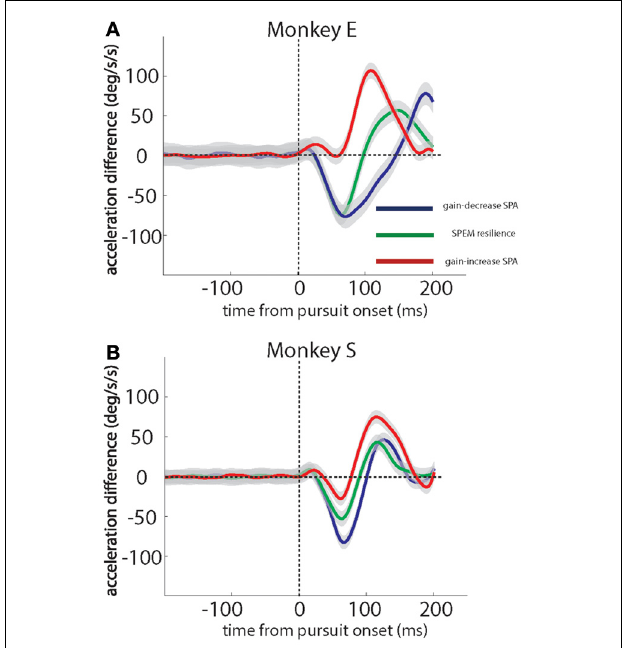
FIGURE 3 | Grand averages of eye acceleration profile differences based on a comparison of the first and the last quarter of trials in individual sessions for the 2 monkeys studied. Gain-decrease SPA (blue), SPEM resilience (green) and gain-increase SPA (red). Data for monkey E in (A) , for monkey S in (B) . Monkey E and monkey S contributed 7 and 11 sessions of gain-decrease SPA, respectively, 7 and 5 sessions of SPEM resilience, respectively, and 11 and 10 sessions of gain-increase SPA, respectively. The gray shadows around the traces signify standard error.